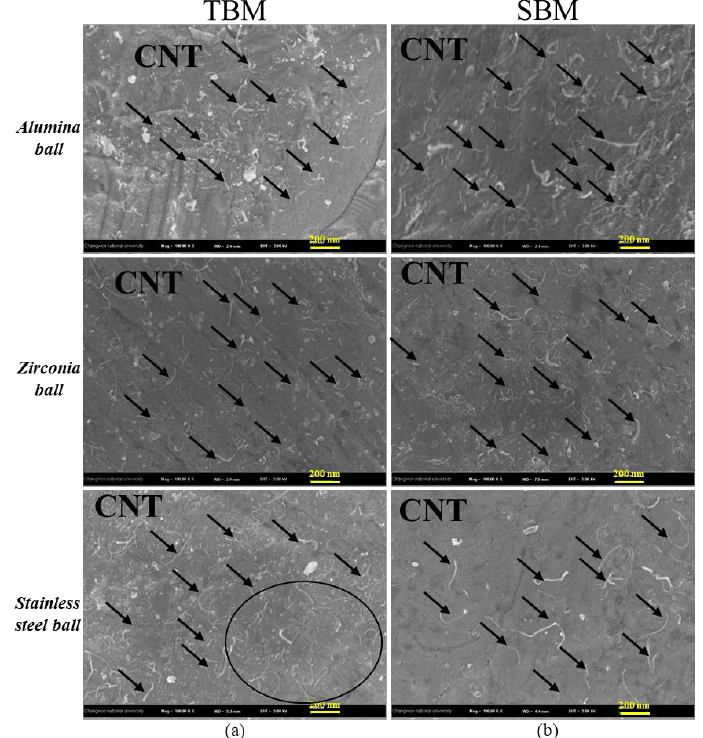
Figure 6. FESEM images (100,000 × ) of Cu / CNT nanocomposites for 12 h at 50 rpm in both mills ( a ) TBM and ( b ) SBM with three different milling media.